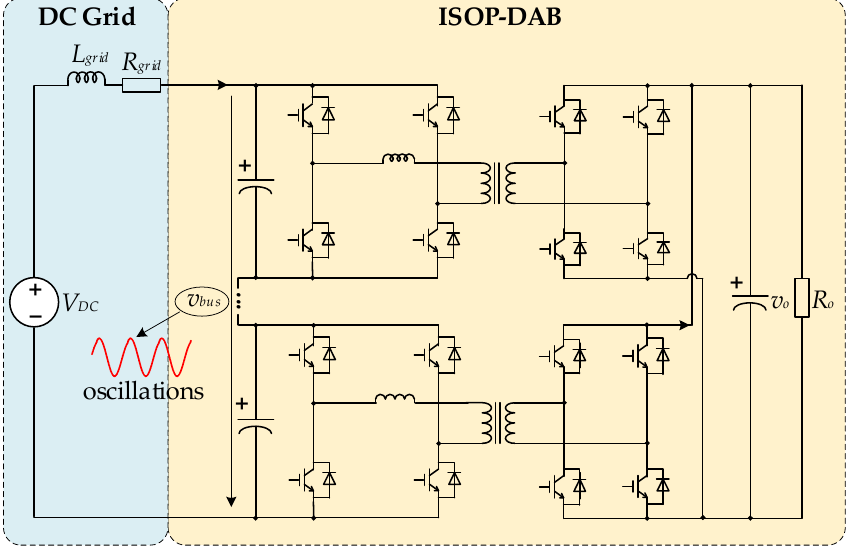
Figure 7. Cascaded ISOP-DAB structure involved in a M-LVDC distribution system.